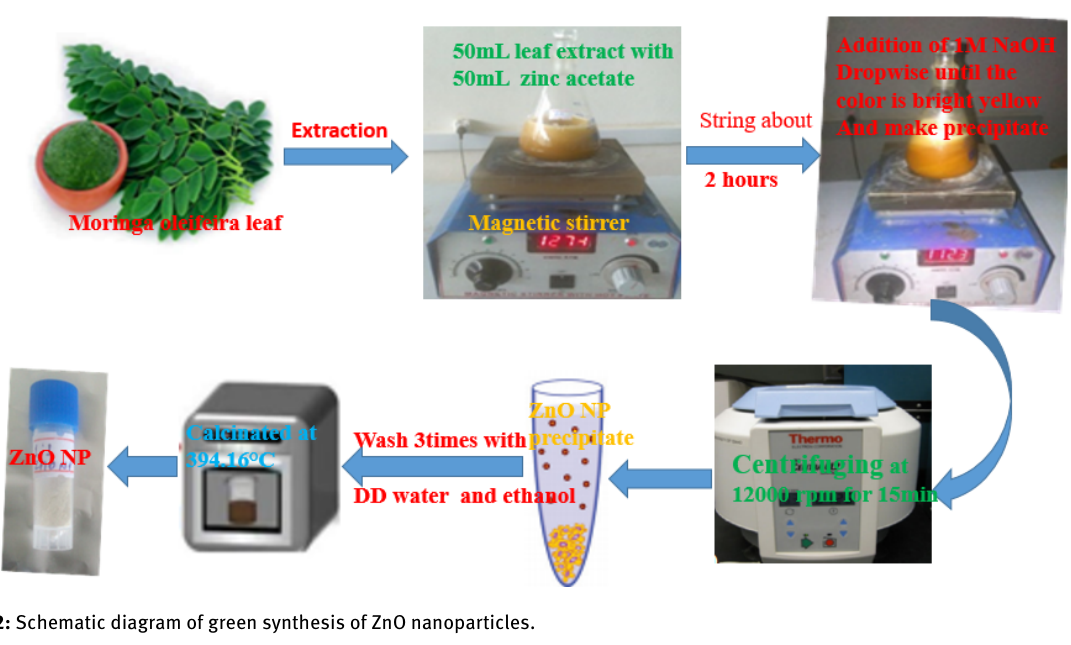
Figure 2: Schematic diagram of green synthesis of ZnO nanoparticles.